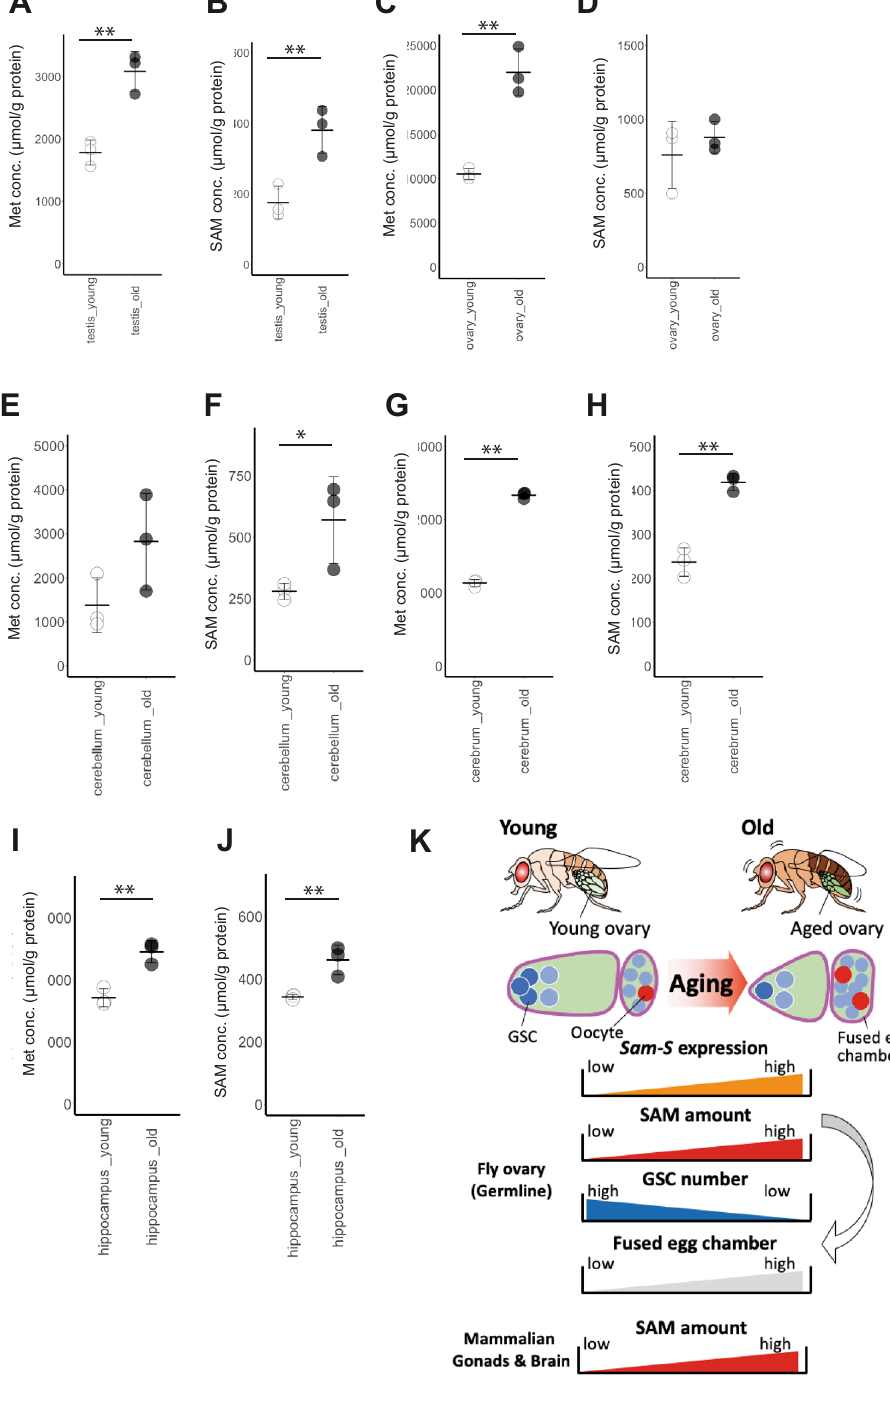
Figure 3. Age-related changes in Met metabolism in mouse tissues. ( A – J ) Comparisons of age-related changes in the Met and SAM levels in mouse reproductive tissues ( A , B ; Testis, C , D ; Ovaries), and parts of brains ( E , F ; Cerebellum, G , H ; Cerebrum, and I , J ; Hippocampus). Both Met and SAM levels increased during aging in all the tissues investigated. For quantification of metabolites from mouse tissues, three samples from each tissue in respective age were examined. In all the panels, statistical significance was calculated using Weltch’s t -test; *indicates p < 0.1, and **indicates p < 0.05. ( K ) Graphical summary of the study. During the aging of fly ovaries, Sam-S dependent SAM biosynthesis increases in the germline. Age-related increase in SAM biosynthesis causes age-related oogenesis defects, decrease in GSC number, and increased fused egg chamber formation. Age- related increase in SAM also occurs in mouse reproductive tissues and the